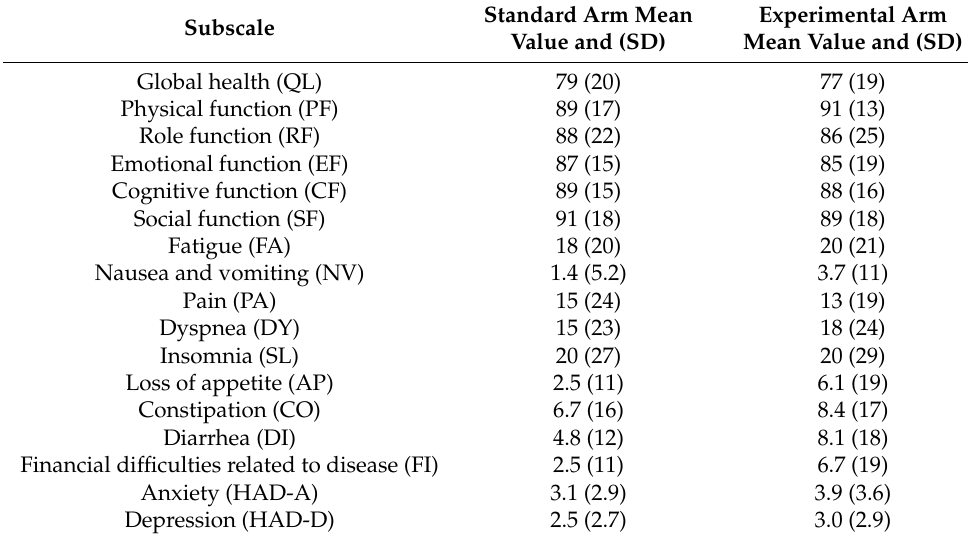
Table 2. Mean scale scores including standard deviation (SD) for each subscale in QLQ-C30, HAD-A and HAD-D at 1 year.